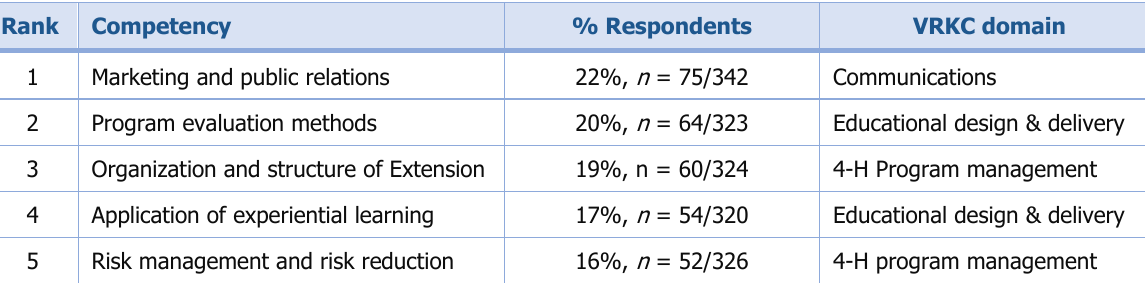
Table 5. Top Five Competencies Volunteers Identified as